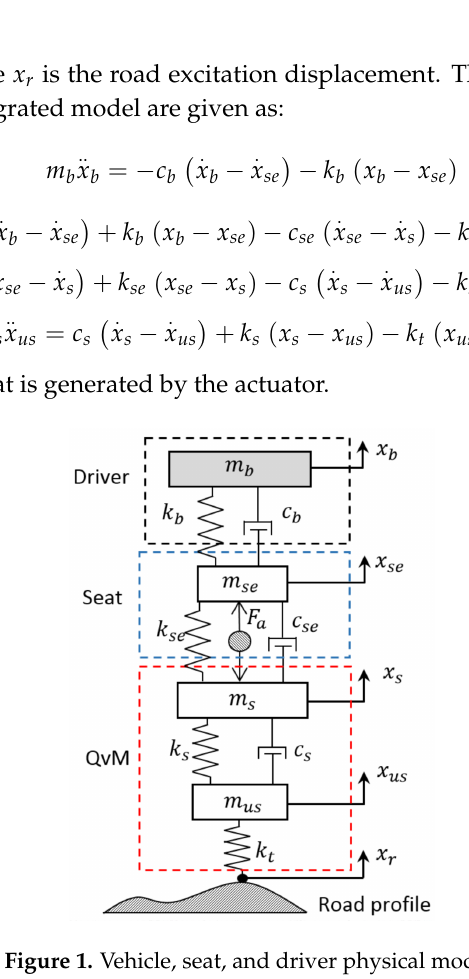
Figure 1. Vehicle, seat, and driver physical model.